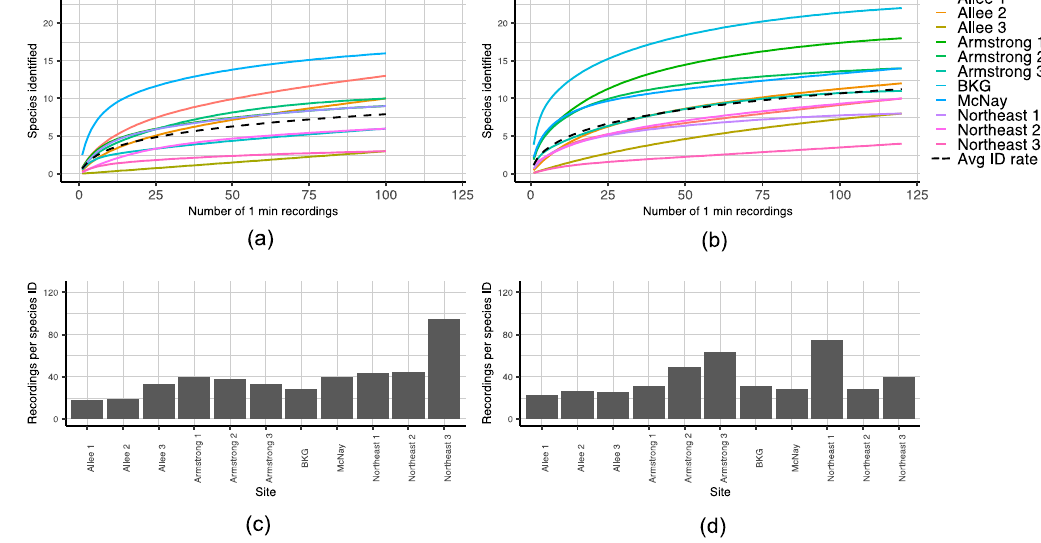
Figure 5. Number of species detected in relation to number of 1-min recordings, illustrating species detection approaching saturation within 100 to 125 recordings. The Bioacoustic Index sorted rank method ( a ) led to a narrower range in species identification than the Dawn recordings method ( b ),